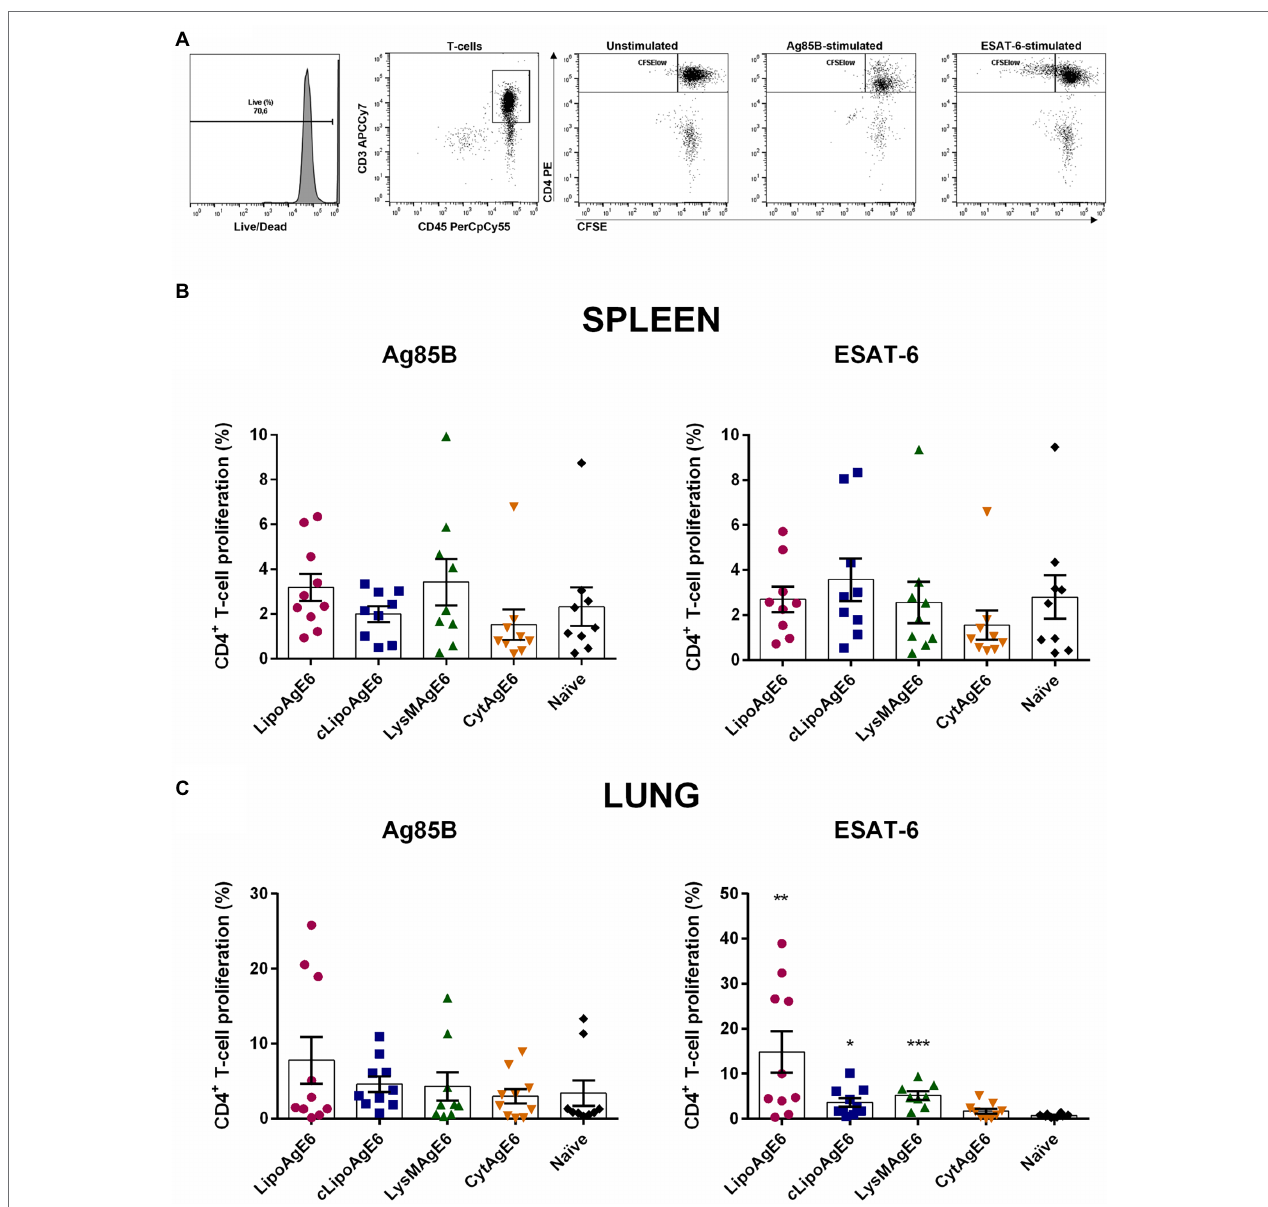
FIGURE 6 | Antigen-specific T-cell proliferation. (A) CD4 + T-cell proliferation was determined by analyzing the carboxyfluorescein succinimidyl ester (CFSE) fluorescence intensity after stimulation with Ag85B and ESAT-6, using unstimulated cells as a threshold for non-specific proliferation. Specific CD4 + T-cell proliferation of splenocytes and total lung cells was determined using a single cell ➔ mononuclear cell ➔ live ➔ CD3 + ➔ CD4 + ➔ CFSE high/low gating strategy. Panels B , C show flow cytometry-based quantification of CD4 + T-cell proliferation for CFSE-stained splenocytes (B) and total lung cells (TLC; C ) from immunized mice that were stimulated with Ag85B or ESAT-6 for 5 days. Results are presented as mean ± SEM of the samples ( n = 8–10). Statistics were performed on log-transformed data (data not shown) to meet the ANOVA assumptions. Statistically significant differences relative to naïve mice were determined using one-way ANOVA with Games- Howell post-hoc test. * p < 0.05, ** p < 0.01, and *** p <